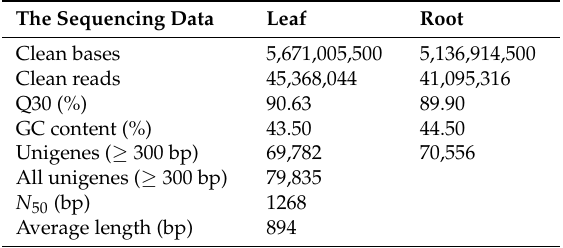
Table 1. Summary of the sequencing data of the leaf and root transcriptome of C. arachnoidea . The Sequencing Data